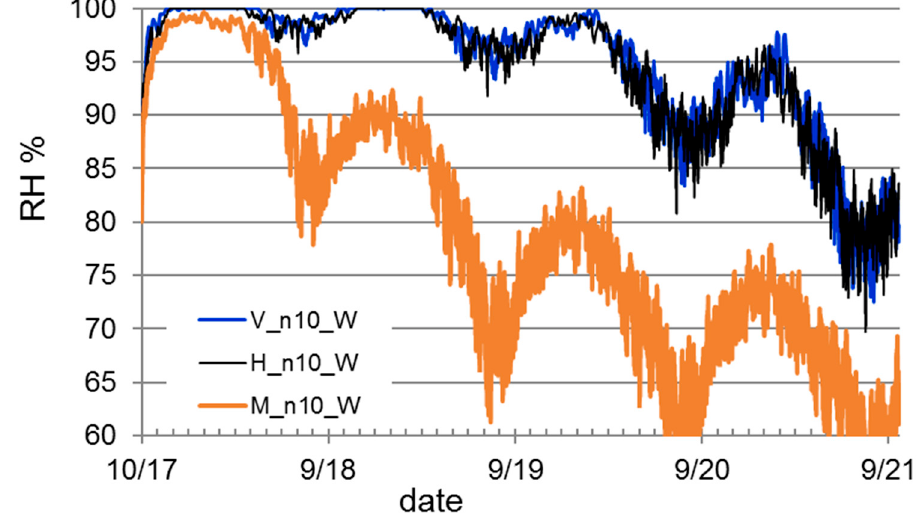
Figure 18. Concrete sandwich wall, wet exterior core, ventilation scheme 1, n = 10 1 / h. The solved relative humidity in the boundary between mineral wool back layer insulation and the PU-insulation of the panel in three different climates during the four-year simulation period.